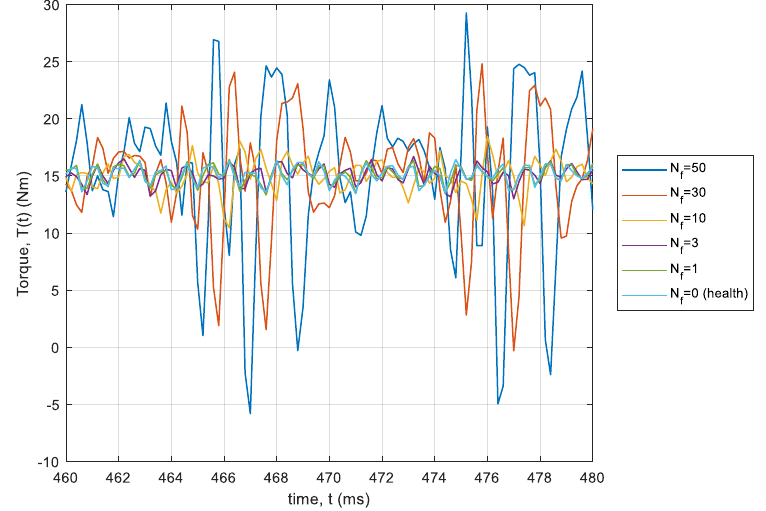
Figure 10. Torque waveforms at steady state (time: 460–480ms) and T L = 15 Nm.